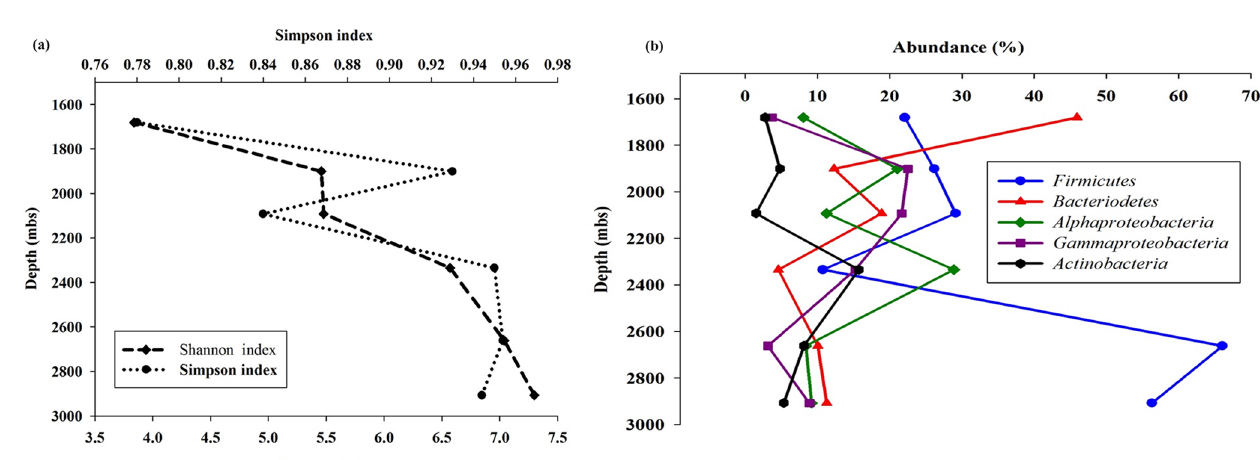
Figure 3. (a) Variation in Shannon and Simpson diversity indices across depths and (b) abundance of the top five bacterial groups across